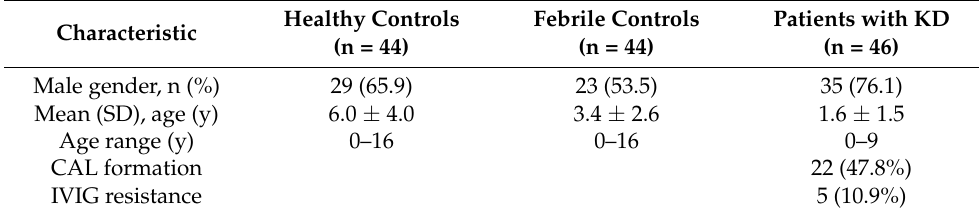
Table 3. Basal characteristics of patients with KD and